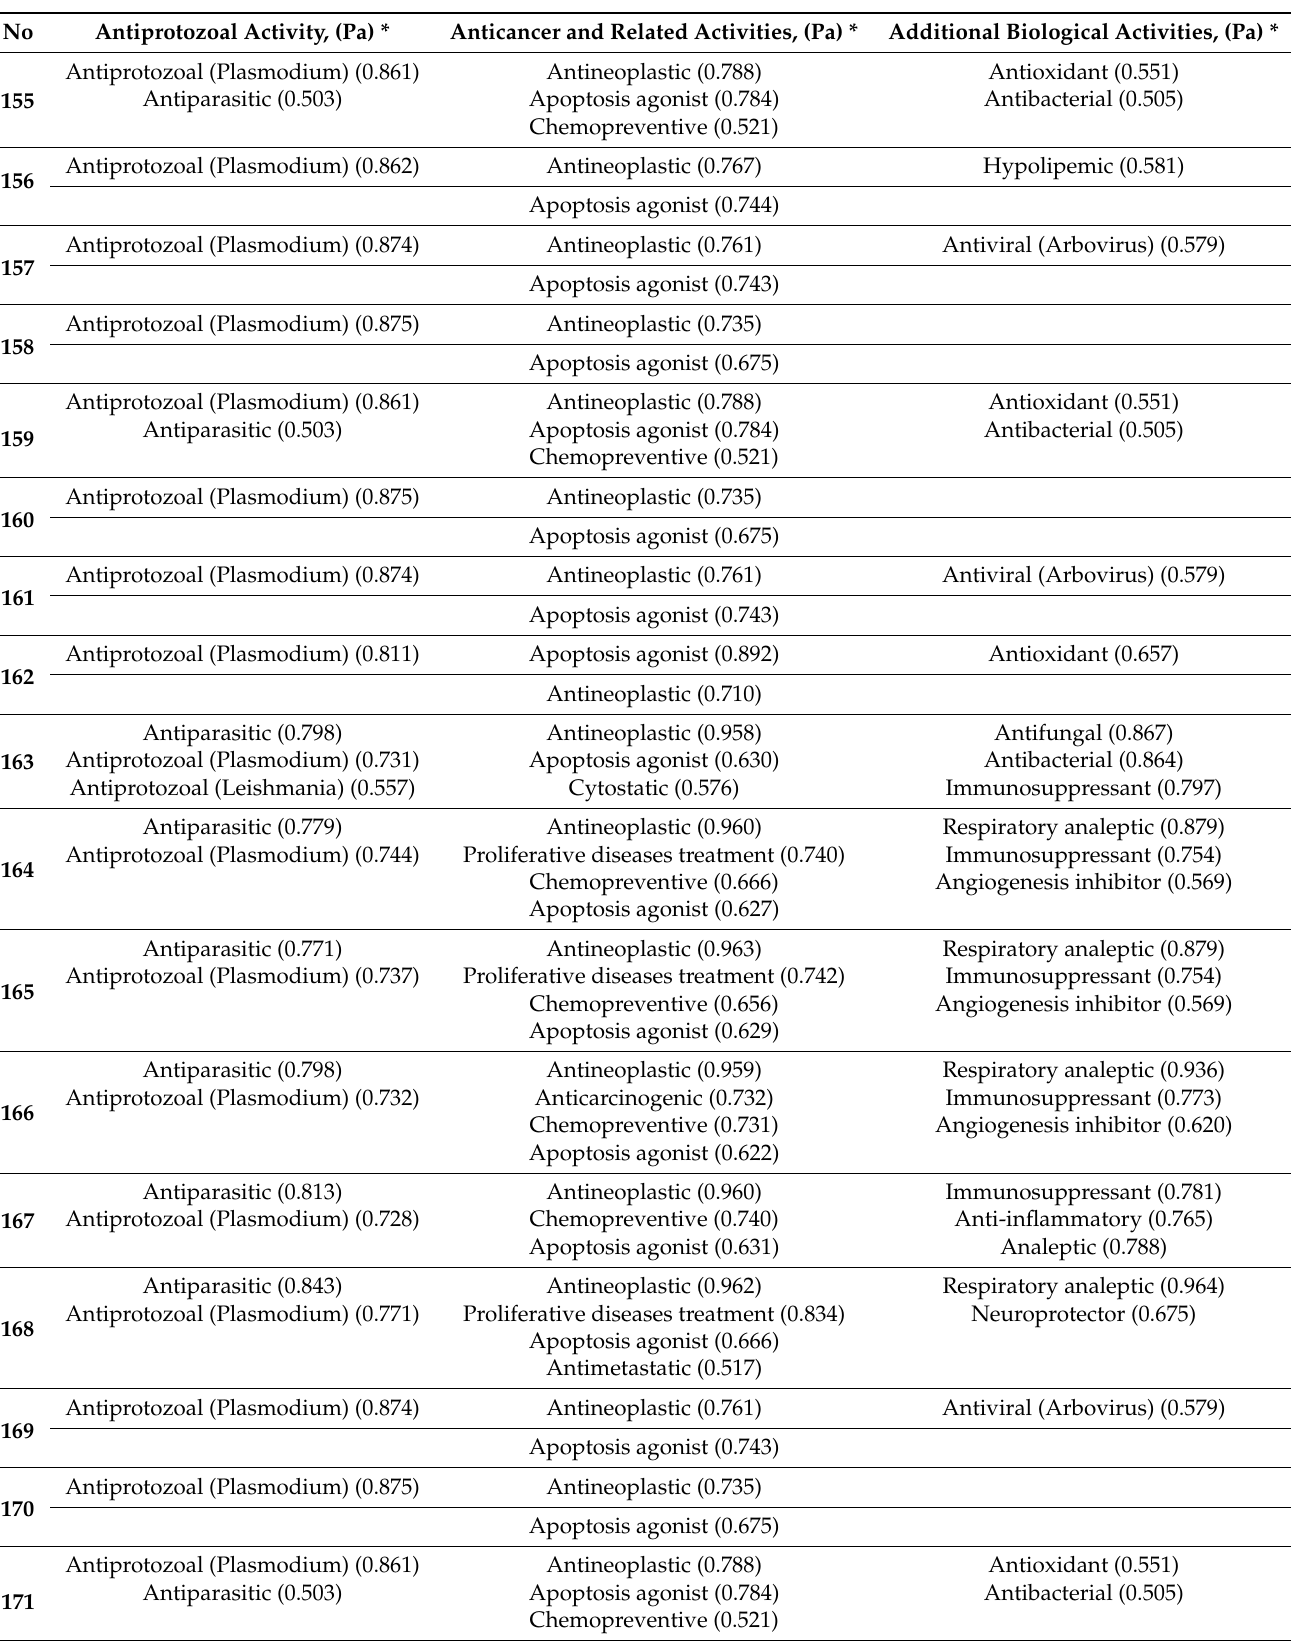
Table 11. Biological activity of natural polycyclic peroxides derived from